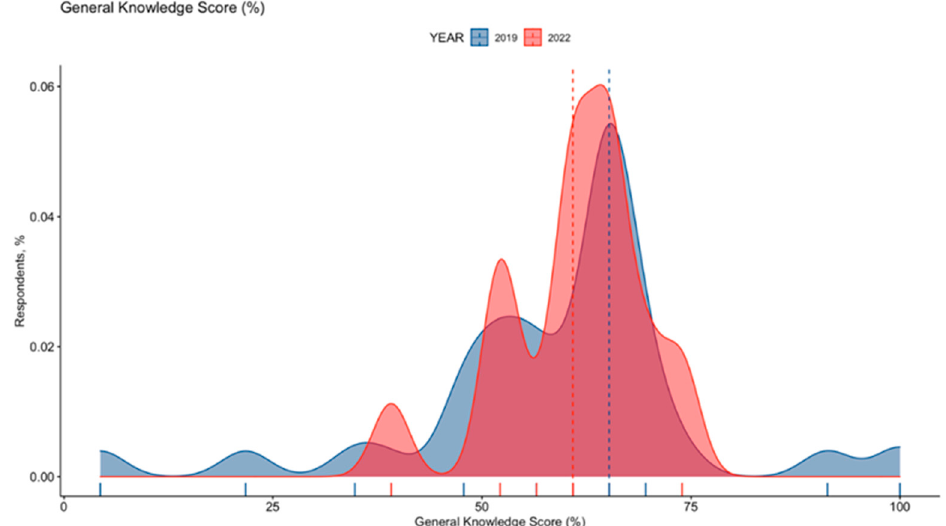
Figure 2. General Knowledge Score (GKS) on Travelers’ Diarrhea in 371 Italian occupational physicians participating in the survey, broken down by year of recruitment (i.e., 2019 vs. 2022). GKS was substantially skewed (D’Agostino–Pearson’s normality test K2 = 151.6, p -value < 0.001). Dotted lines represent median value.